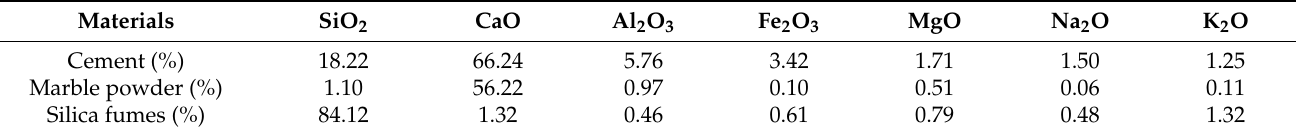
Table 1. Chemical properties of used cement, marble powder and silica fumes.